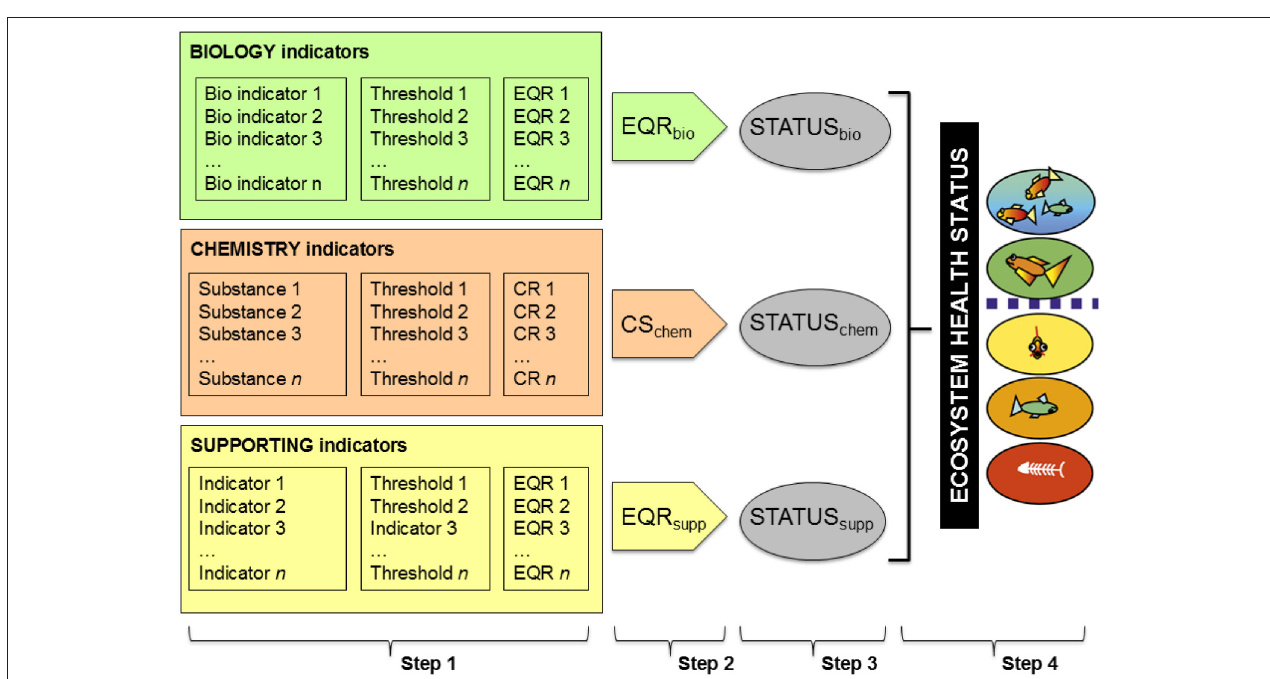
FIGURE 3 | Conceptual model of the HELCOM HOLAS tool. Indicators used for thematic assessment are integrated by weighted averaging in three categories (steps 1 and 2), and the score-based classifications (step 3) are further integrated by the “One Out-All Out” principle (step 4). The fish represent the five status classes: high (blue), good (green), moderate (yellow), poor (orange), and bad (red) (see text and Andersen et al., 2014 for further details). EQR, Ecological Quality Ratio.